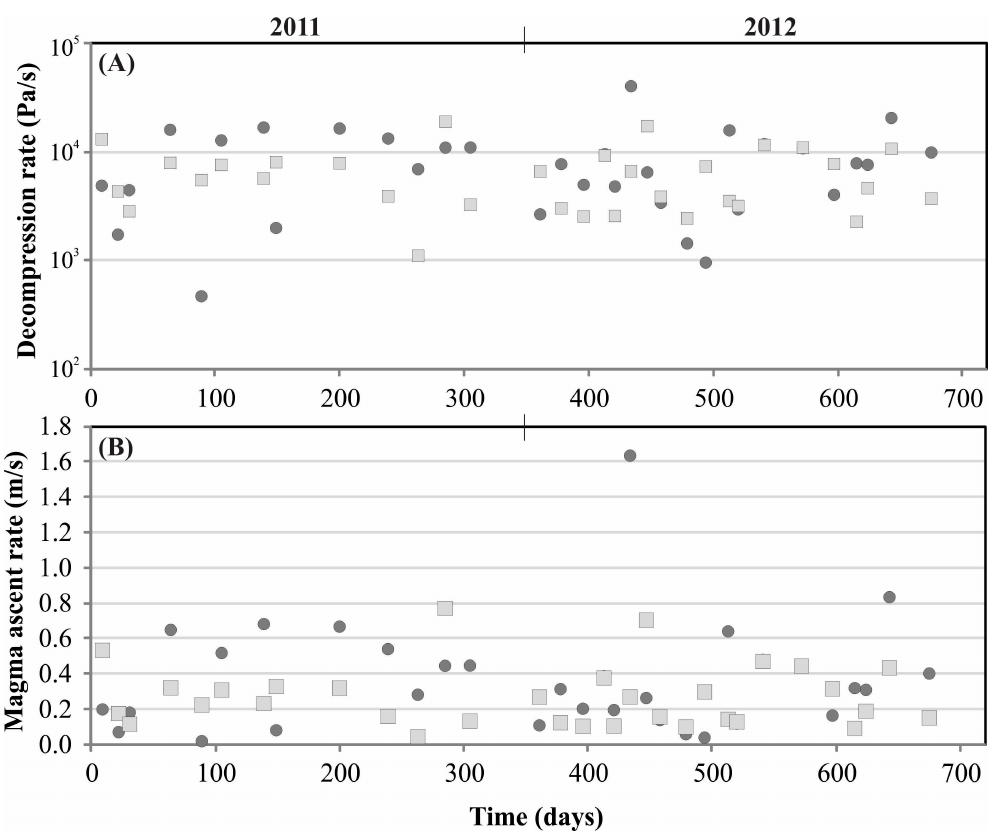
Figure 8. The result of estimation of ( A ) decompression rate and ( B ) magma ascent rate. Solid rectangle for BVVR and solid circle for BVR. Table 2. The result of estimation of decompression rate (Pa/s) and magma ascent rate (m/s) based on Black Vesicular Volcanic Rock (BVVR) and Black Volcanic Rock (BVR) juvenile materials type in Sakurajima at AD